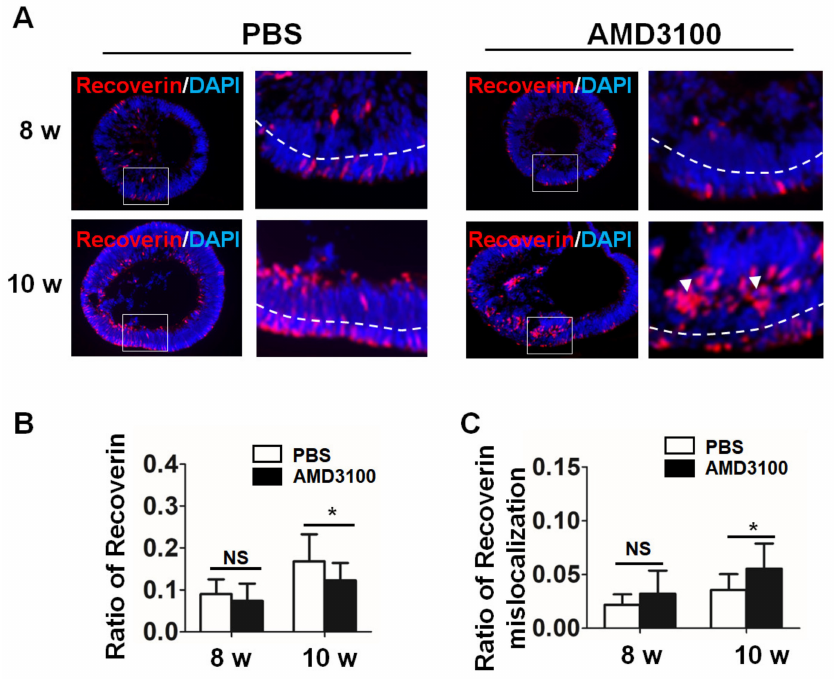
Figure 9. CXCR4 blockade leads to a decrease in the number of photoreceptor precursors and their mislocalization. ( A ) Photoreceptor precursor cells were stained for RECOVERIN from 8 weeks to 10 weeks of differentiation, and RECOVERIN staining showed mislocalization in the AMD3100 treatment group (white arrow). ( B ) The relative ratio of RECOVERIN-positive cells to all cells (nuclei were stained with DAPI) significantly decreased in the AMD3100 group (* p < 0.05, NS: Not Significant, p > 0.1, n = 15). ( C ) The relative ratio of RECOVERIN-positive cells to all cells (nuclei were stained with DAPI) in the INBL cluster (inside the dotted line) significantly increased in the AMD3100 group (* p < 0.05, NS: Not Significant, p > 0.1, n = 15). Scale bars: 100 µ